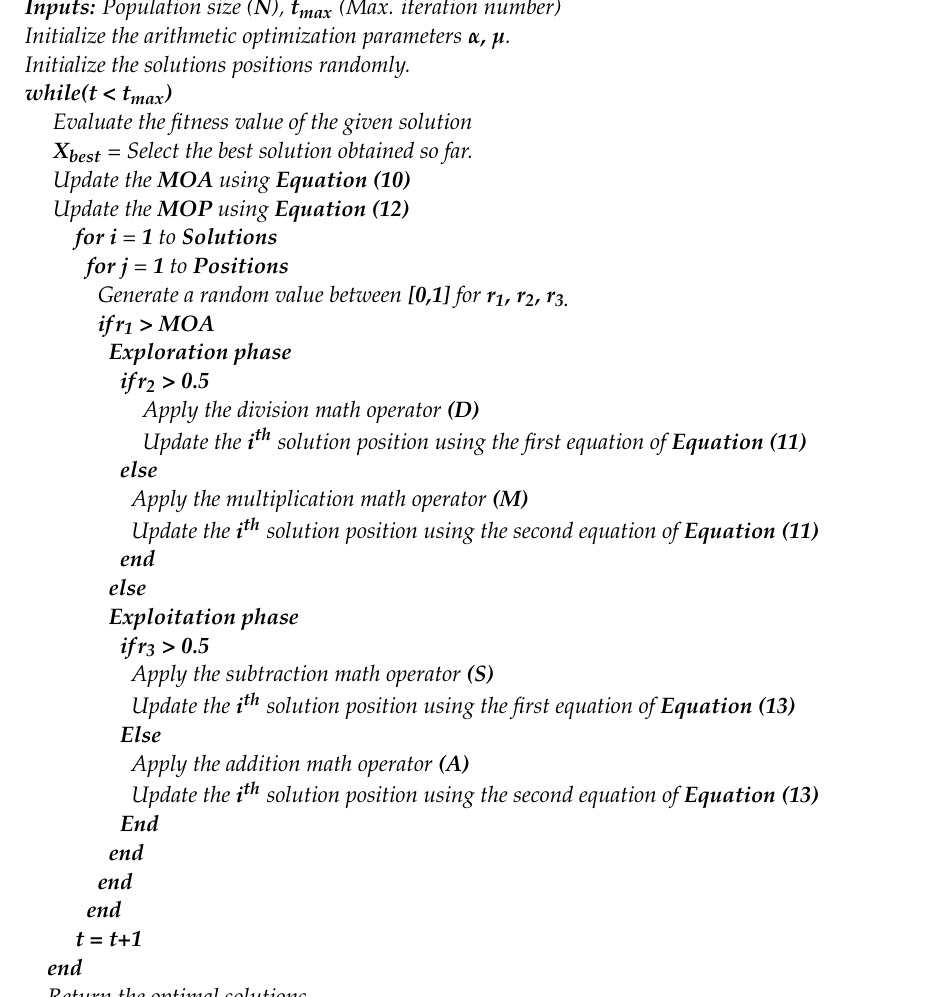
Algorithm 2 Pseudocode of Arithmetic Optimization